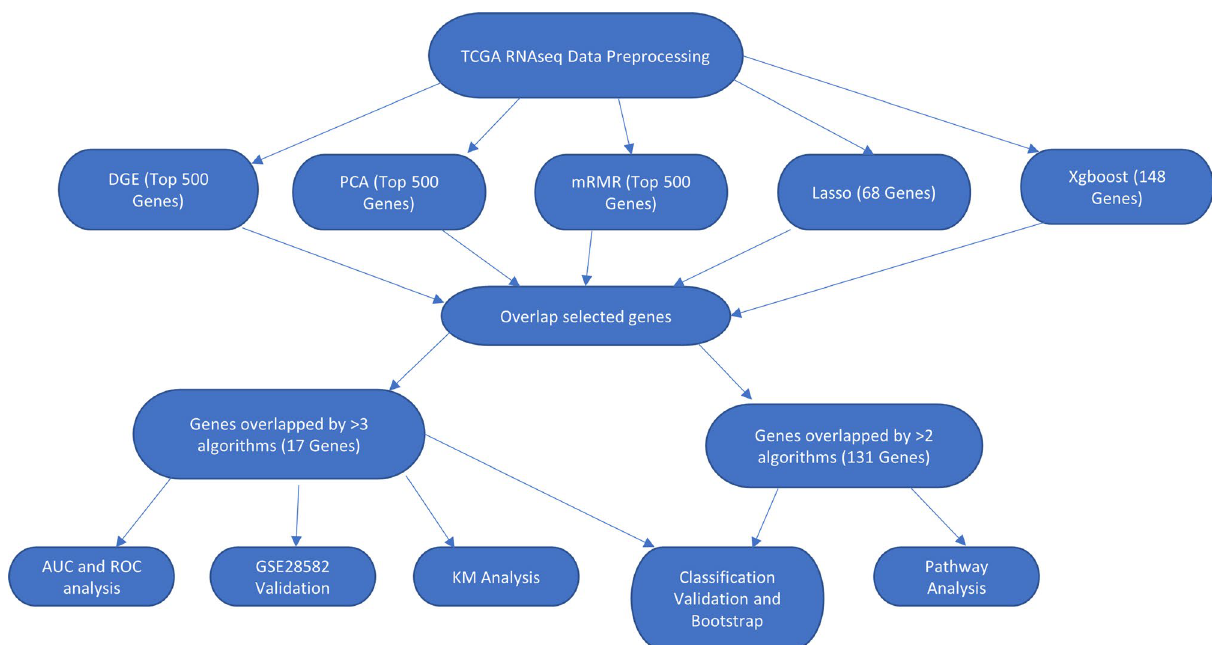
Figure 1. An overview of the experimental design. A scheme summarizes the selection methods and the numbers of the resulting overlapped